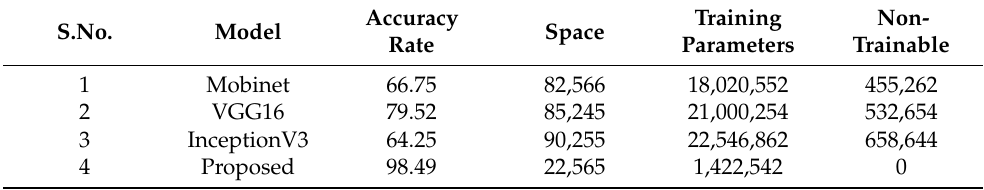
Table 3. Comparison with other models .